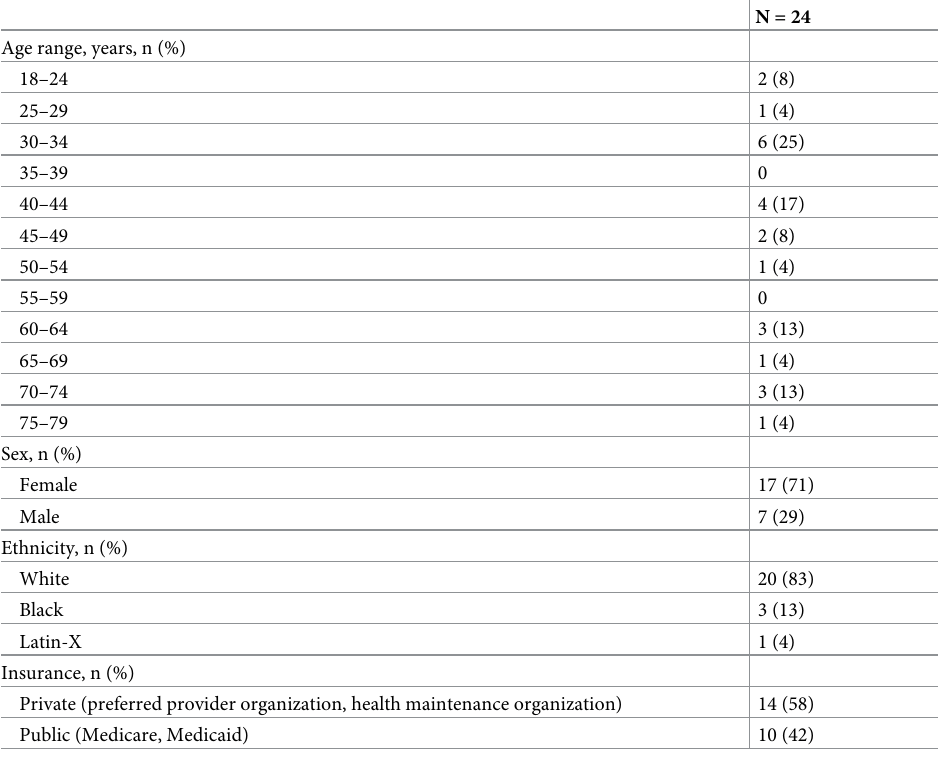
Table 1. Demographics and characteristics of